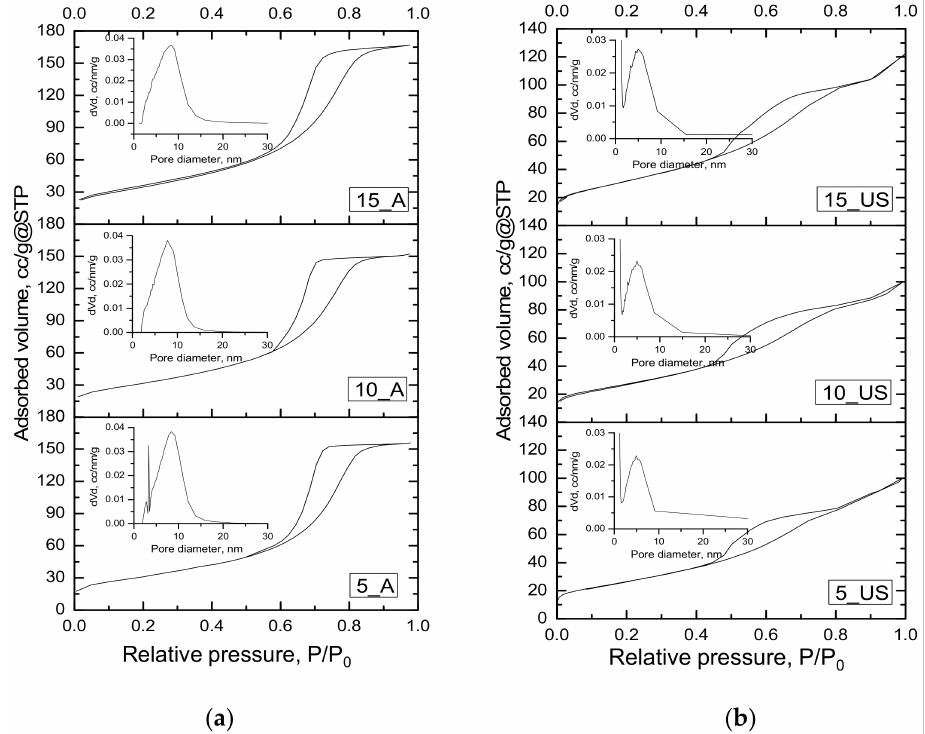
Figure 2. Nitrogen adsorption-desorption isotherms for titania samples: ( a ) A-series; ( b ) US-series, and the corresponding BJH pore size distributions calculated using adsorption branch